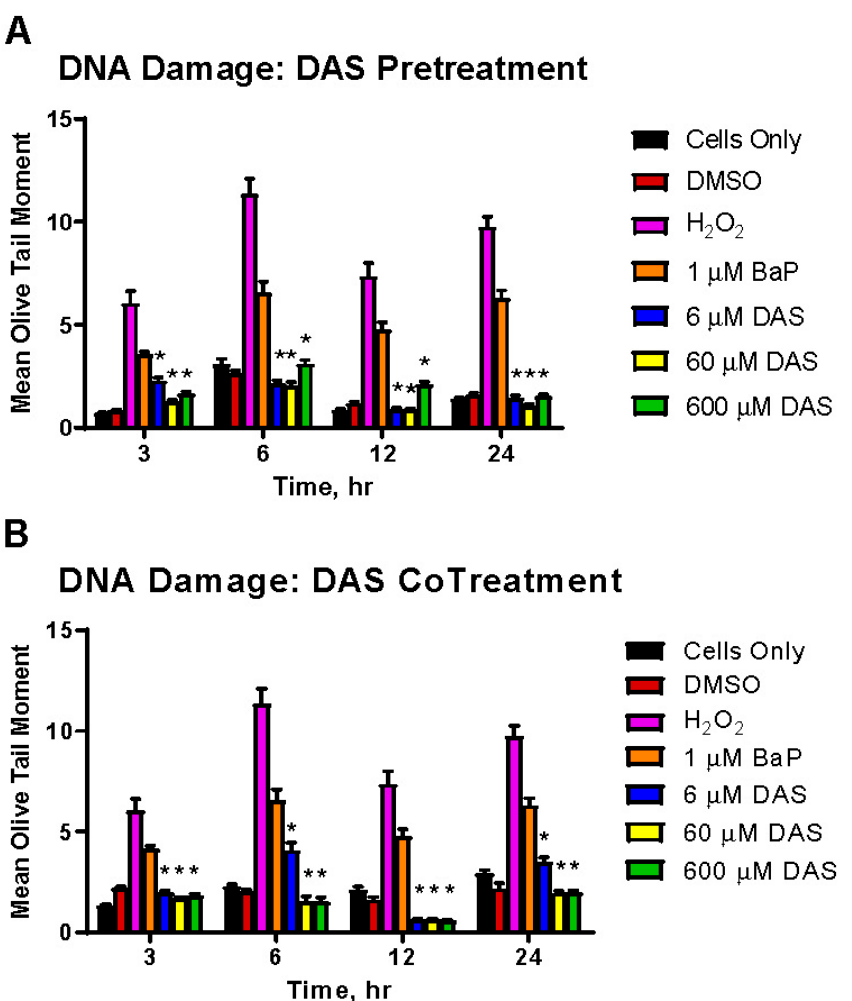
DAS (60 or 600 µ M). Following 24 h treatment, MCF-10A cells were harvested and lysed using a protease cocktail with lysis buffer. Protein expression was measured using Western analysis by automated capillary electrophoresis. The protein expression of all treatments was normalized using GAPDH loading control. All treatments were compared to the 1 µ M BaP treatment (Figure 7A,B). Exposure to 1 µ M BaP reduced POL β expression when compared to the control. Co-treatment with 60 µ M DAS and 1 µ M BaP significantly ( p < 0.001) increased the DNA polymerase expression when compared to 1 µ M BaP alone, while CoTx with 600 µ M DAS and BaP decreased expression (Figure 7A,B).